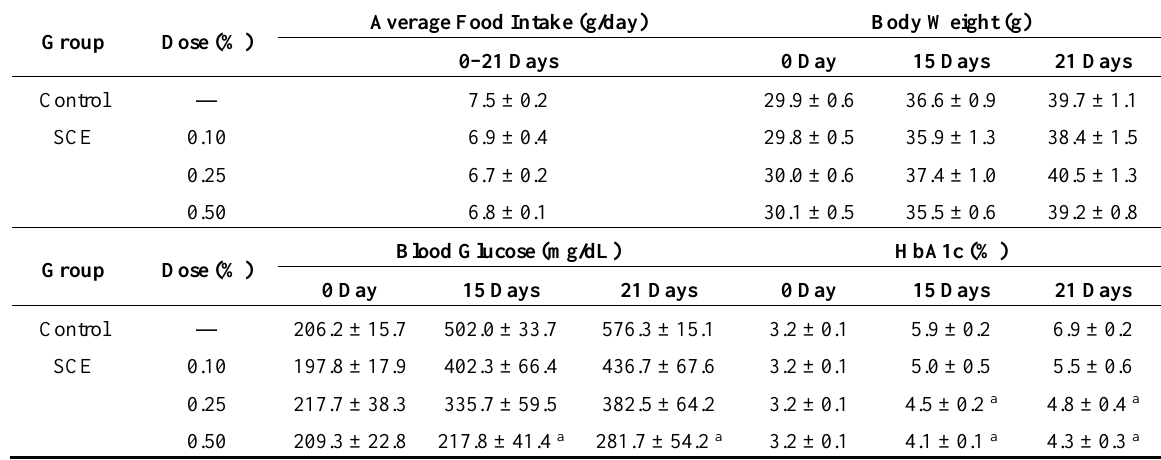
Table 4. Effects of chronic administration of SCE on blood glucose and HbA1c levels in CE-2 diet-fed KK-A y mice.